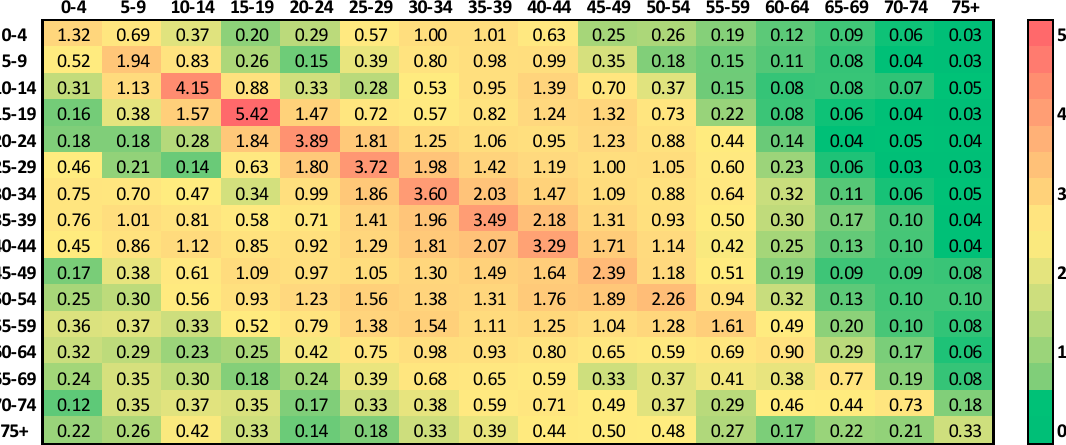
Figure 3. Contact matrix for a policy of school closure and no social distancing in Seoul and Gyeonggi province. Table 3. Overview of the constants and contact matrixes used for each policy.